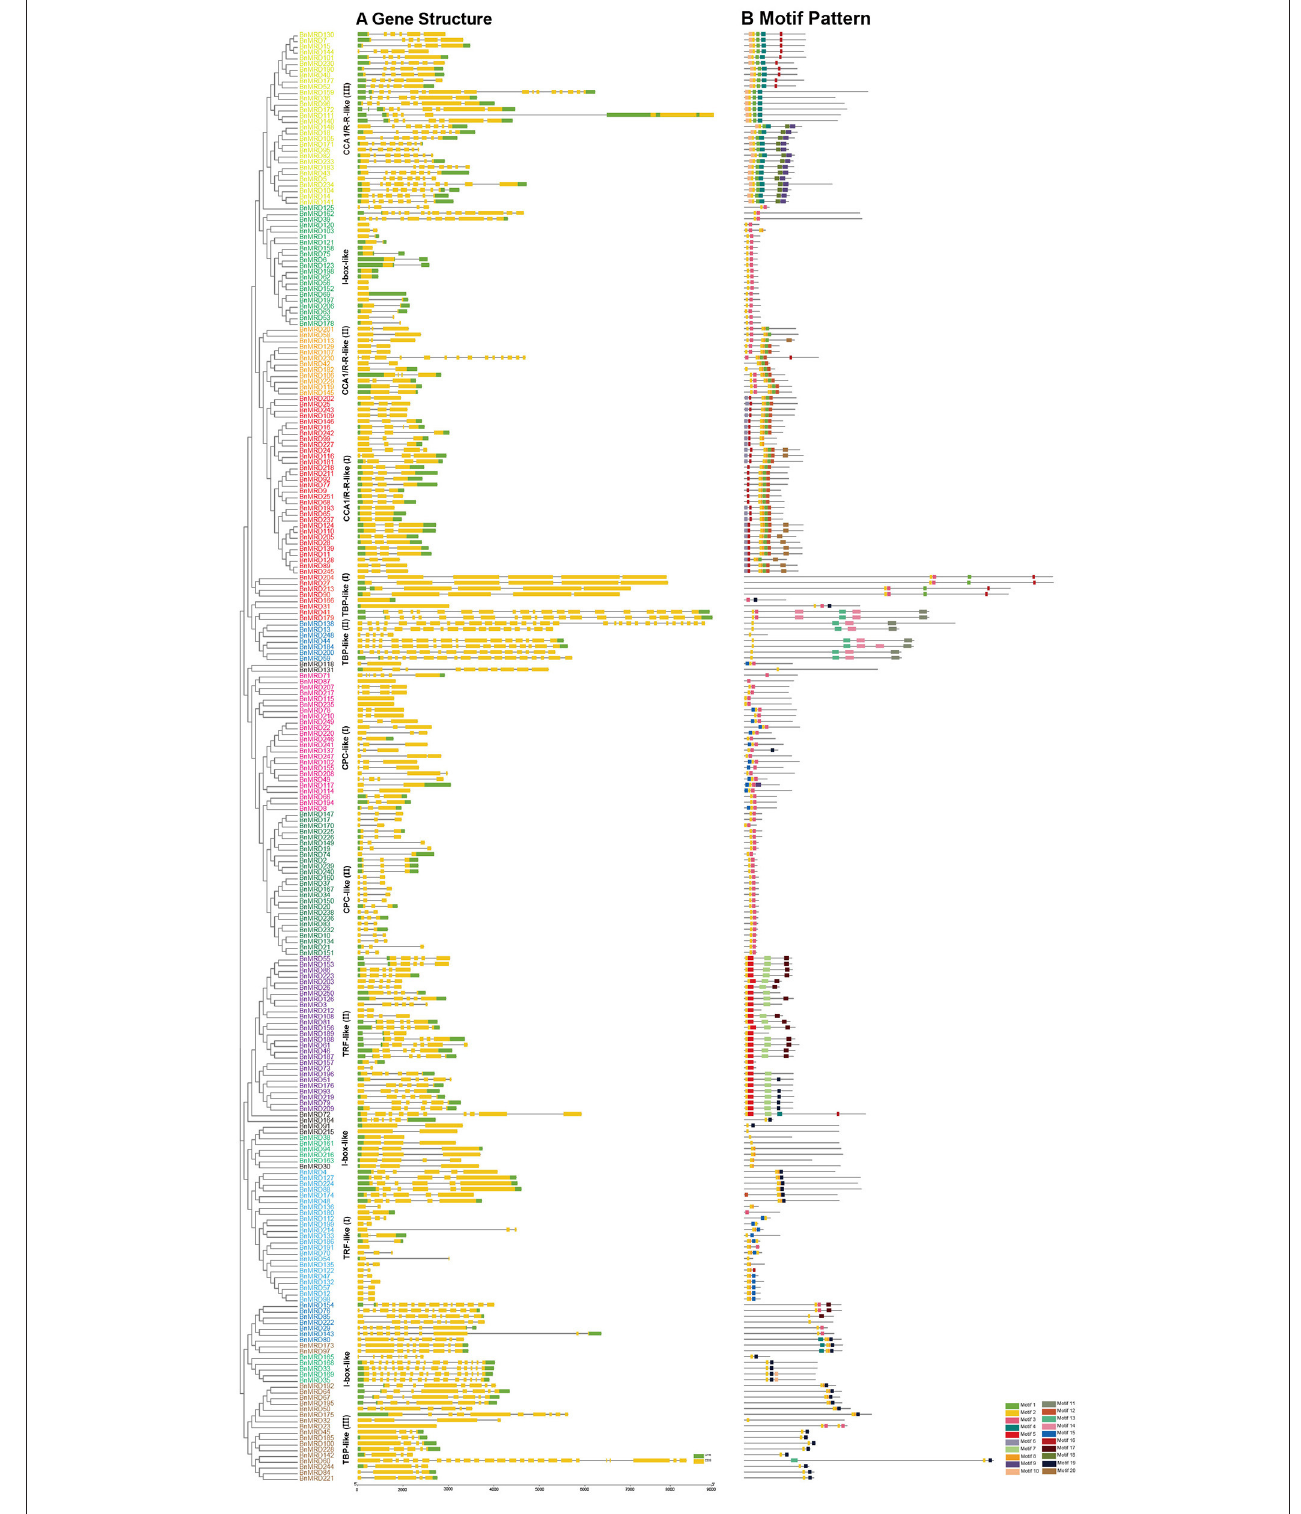
FIGURE 2 | Gene structures and motif compositions of MYB-related proteins in B. napus . (A) Exon-intron structures of BnMYB-related proteins. Green boxes indicate 5 ′ - and 3 ′ -untranslated regions (UTR), respectively. Yellow boxes indicate exons, and black lines indicate introns. (B) Distribution of conserved motifs in BnMYB-related proteins. Motifs 1–20 identified by MEME analysis are displayed in different colored boxes.